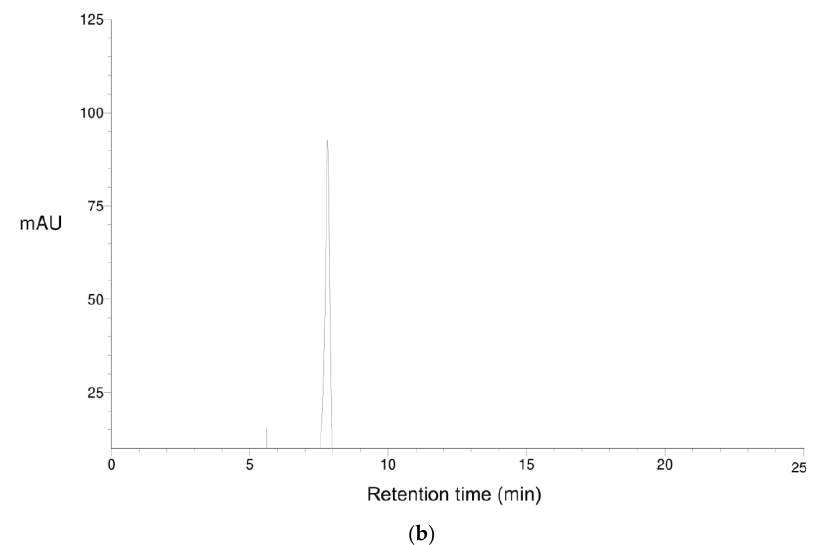
Figure A1. HPLC-chromatogram from the standard (L-ascorbic acid) ( a ) and cassava leaf sample ( b ).